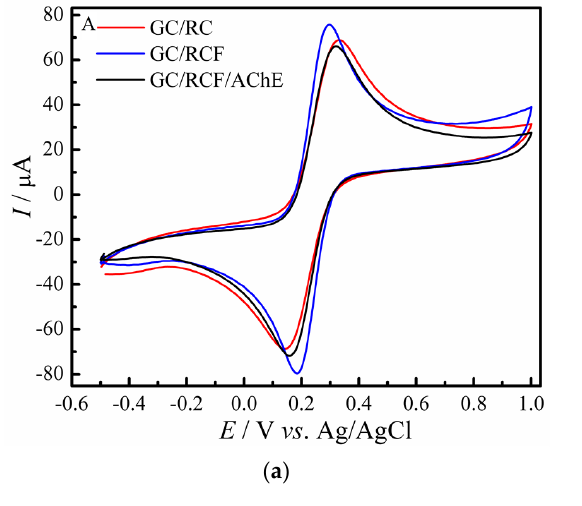
having 0.1 mol L − 1 of KCl and 5.0 mmol L − 1 of the redox couple Fe[(CN) 6 ] 3 − /4 − by ( a ) Cyclic